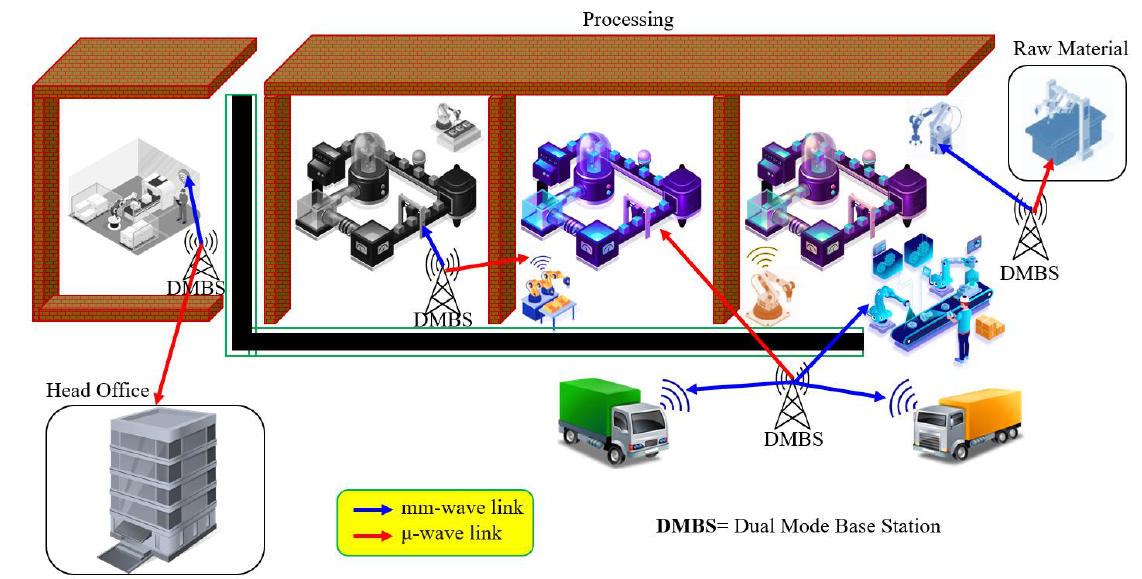
Figure 1. Smart factory scenario.